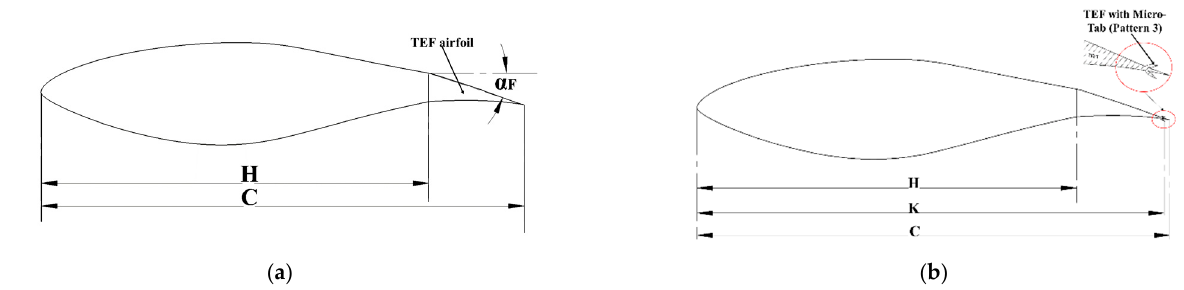
Table 1. The parameters of the airfoil with TEF with Micro-Tab.